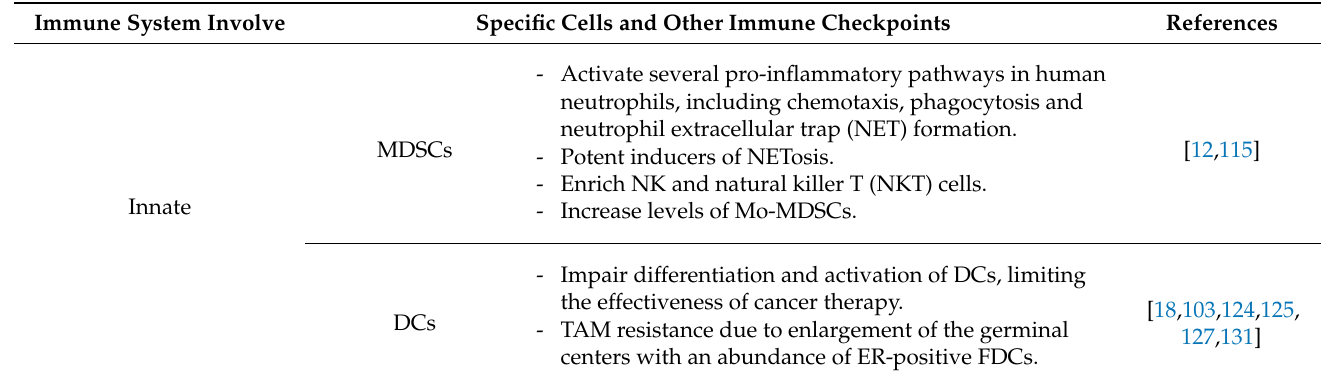
Table 4. Direct effects of TAM via MDSCs and